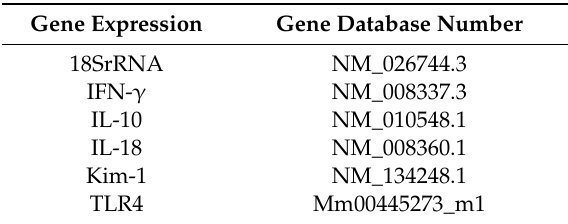
Table 3. Gene database number for analysis of mRNA